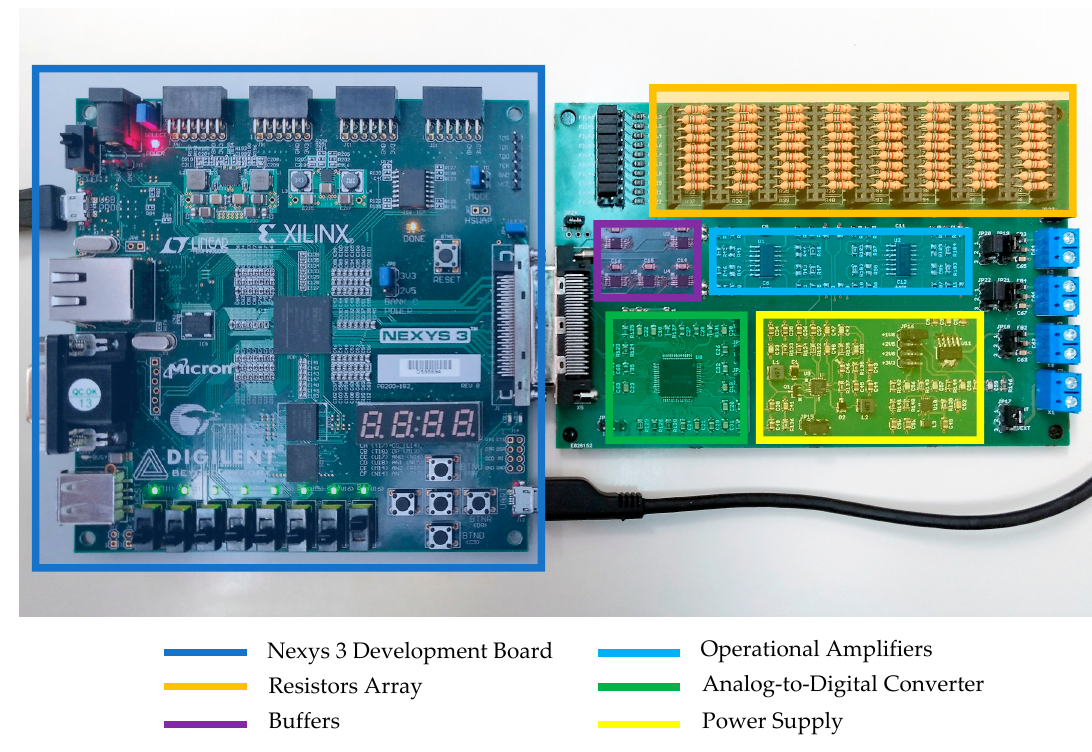
Figure 5. Electronic system used in the experiments presented.